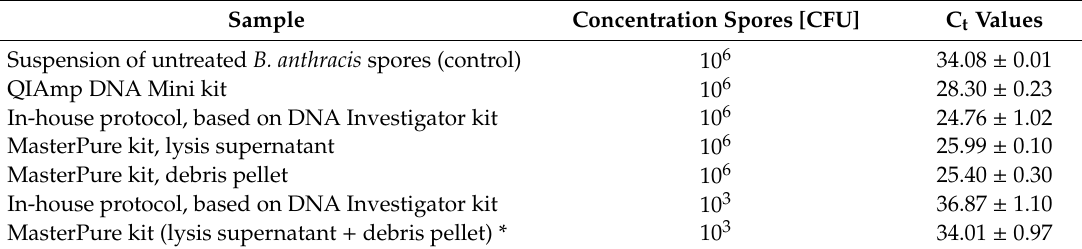
Table 5. A combination of mechanical disruption by bead-beating and DNA extraction with the MasterPure kit resulted in the highest DNA extraction e ffi ciency for B. anthracis spores. C t : cycle